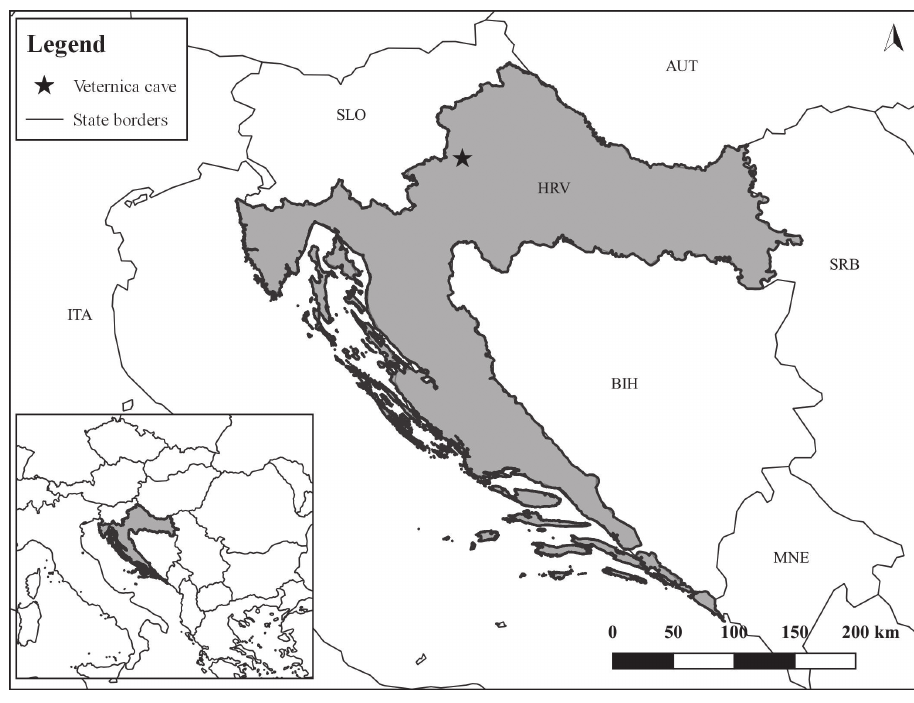
Figure 1. Location of the Veternica cave.